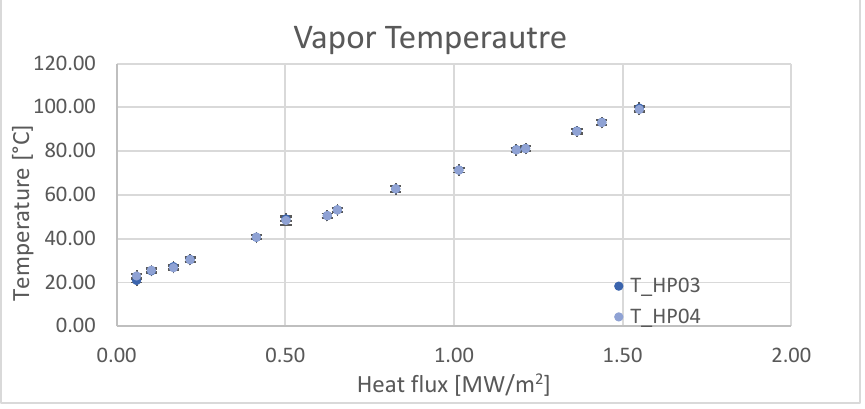
Figure 20 . Vapor temperature of mock-up-2 with electric heater as a function of the heat flux.